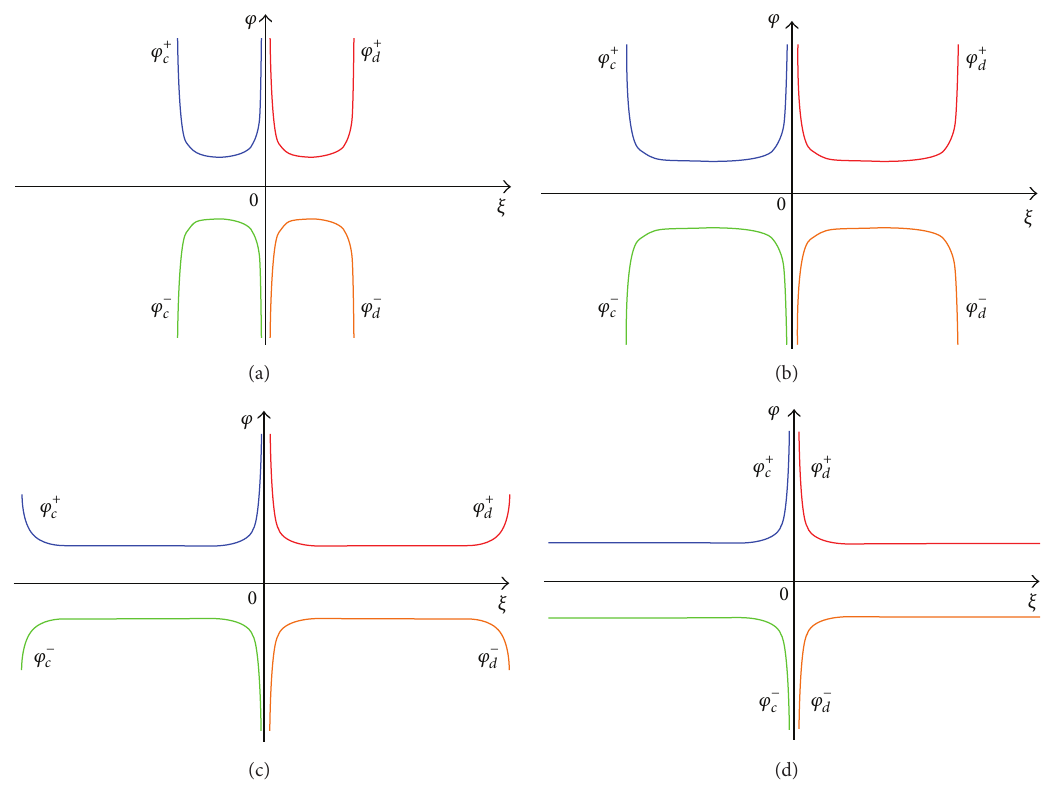
: 𝑝 = 3𝑞 2 /16𝑟 = 3 and (a) 𝑝 = 3 − 10 −1 , (b) 𝑝 = 3 − 10 −3 , (c) 2